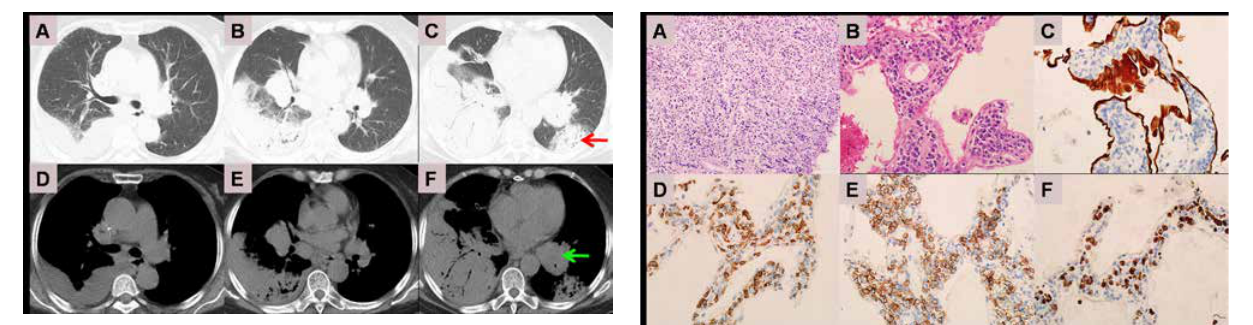
Figure 1: Initial chest computed tomography. Lung window: A B C; mediastinal window: D E F. Red arrow indicates reversed halo sign, and green arrow indicates low density area in left hilar mass.